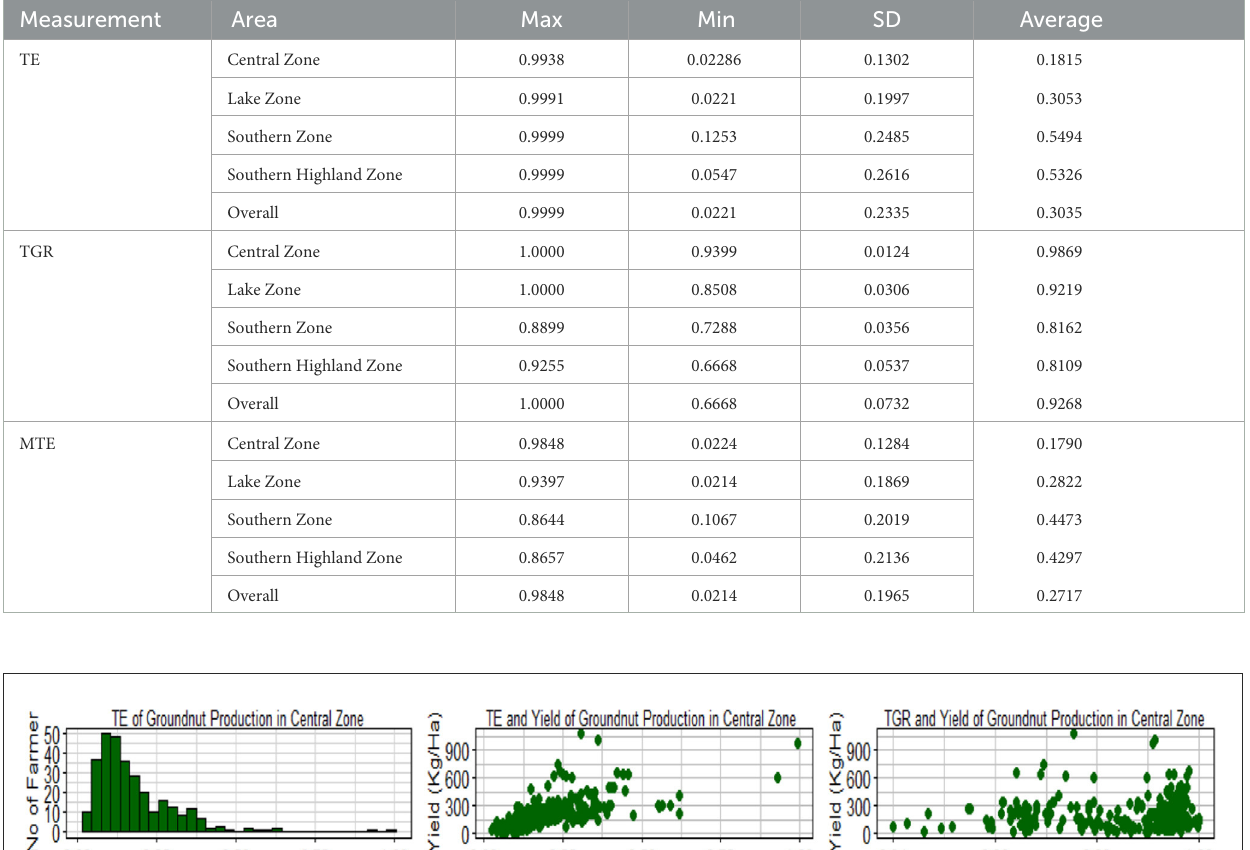
TABLE 4 Summary statistics of various efficiency measure.